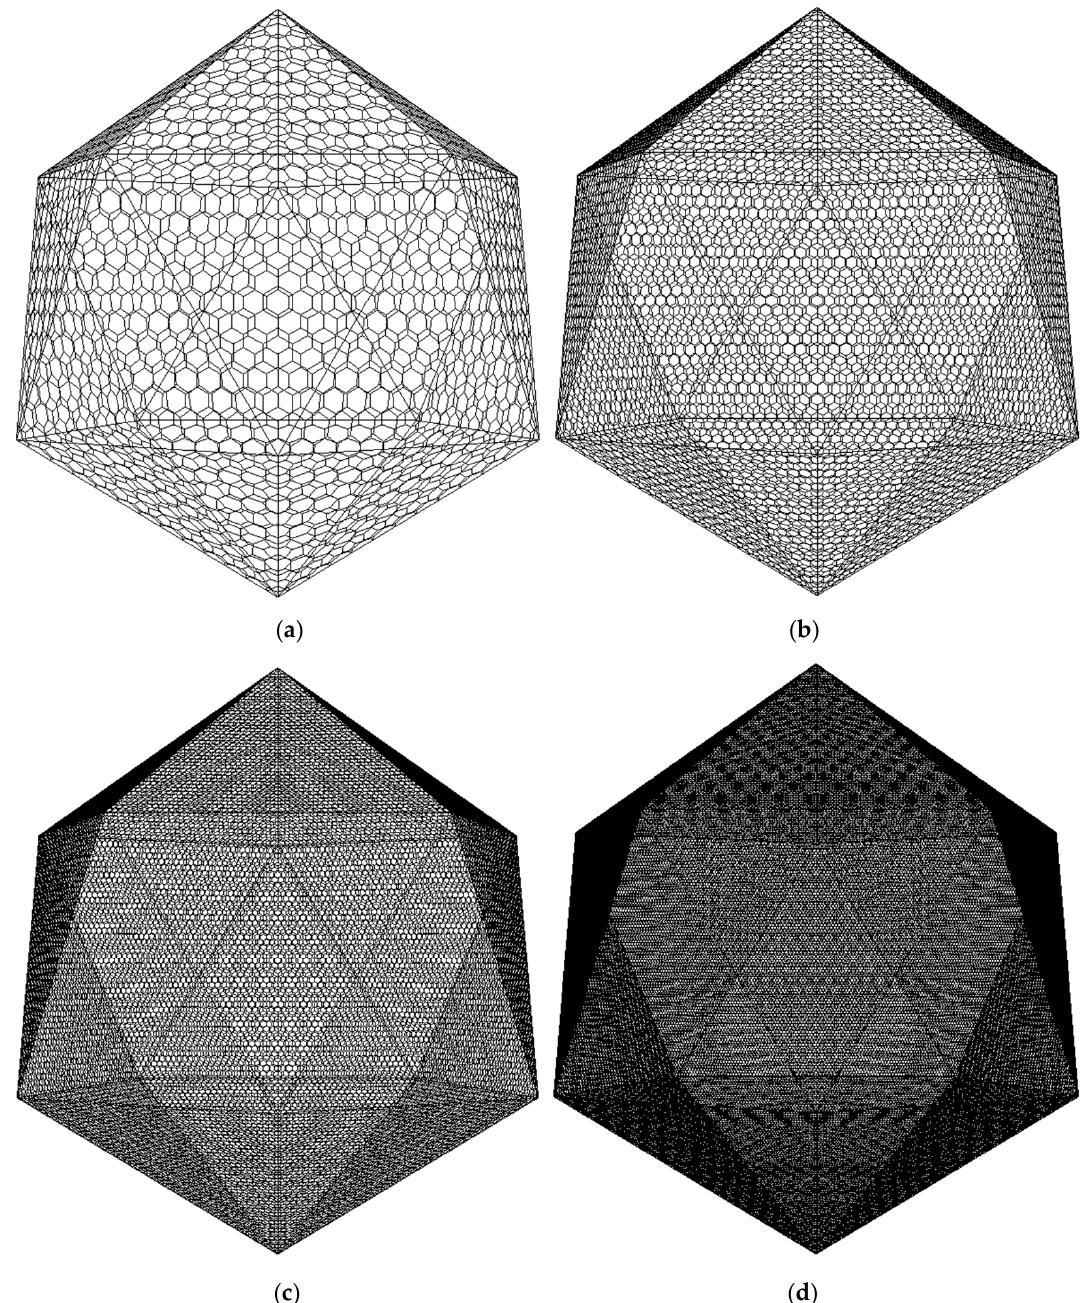
Figure 8. The 3rd, 4th, 5th, and 6th layers of the class I aperture 4 grid on a regular icosahedron. ( a ) the 3rd layer; ( b ) the 4th layer; ( c ) the 5th layer; and ( d ) the 6th layer.